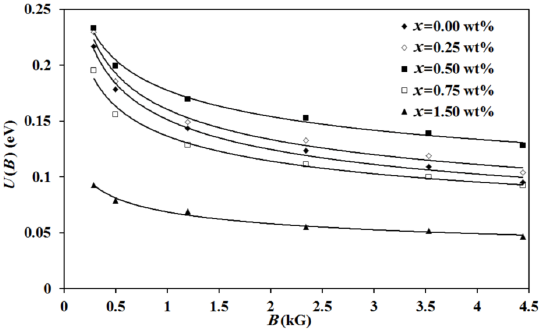
Fig. 7 Relation between U ( B ) and B for (BaSnO 3 ) x / BiPb-2223 samples.